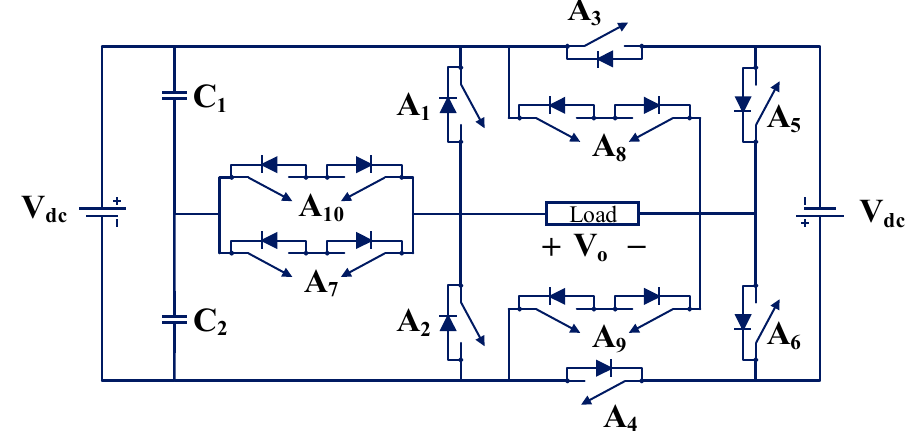
Figure 36. Single-phase nine-level FT MLI (TP39) [71].